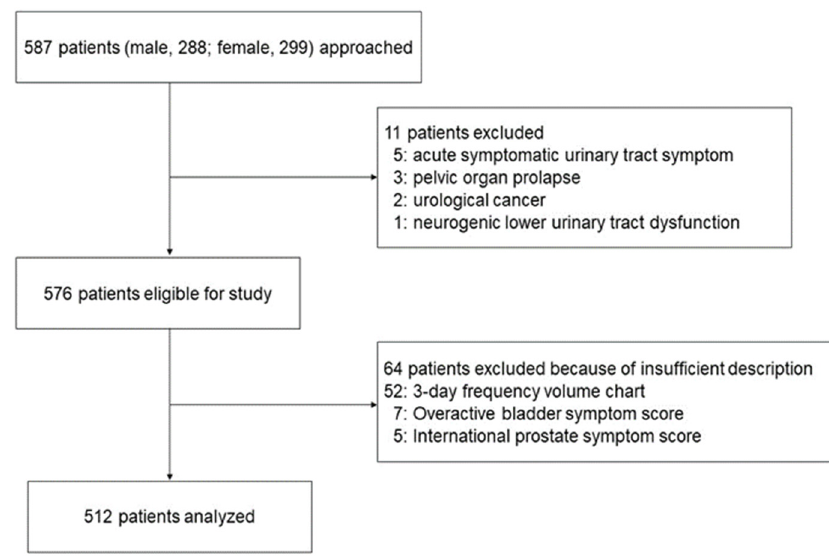
Figure 2. Patient flow